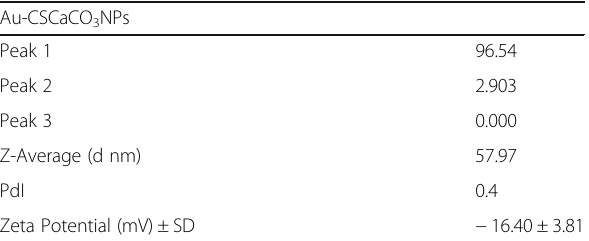
Table 2 Zeta potential of the Au-CSCaCO 3 NPs, their size distri- bution by intensity (d nm), and poly dispersity index (PdI) expressed in mean ± standard deviation